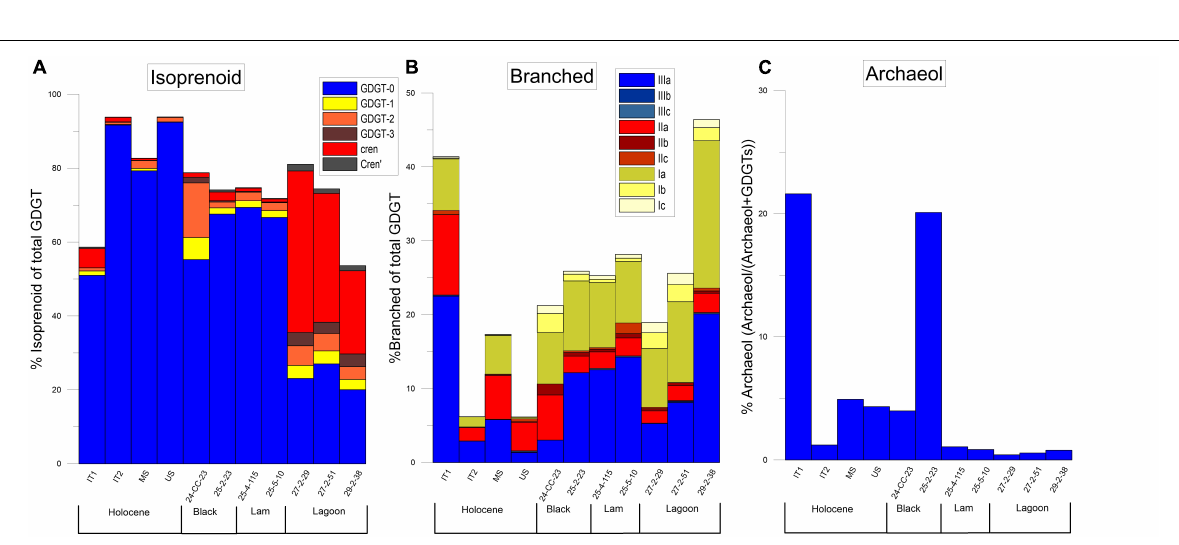
FIGURE 3 | Lithostratigraphy for Hole U1464C with biostratigraphic markers (Gallagher et al., 2017; Groeneveld et al., 2017) and comparison of mineralogy between samples from North-West Australia and Abu Dhabi.